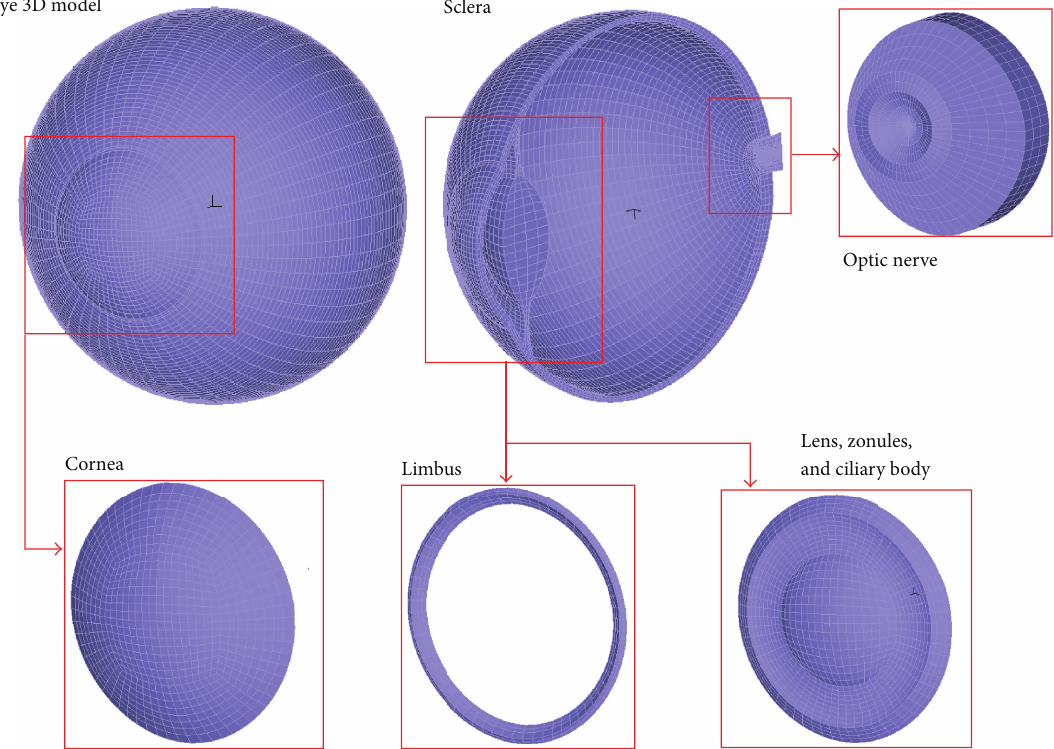
Figure 1: Finite element model of the eye. Components of the model used in this work for the simulation of the scleral buckling